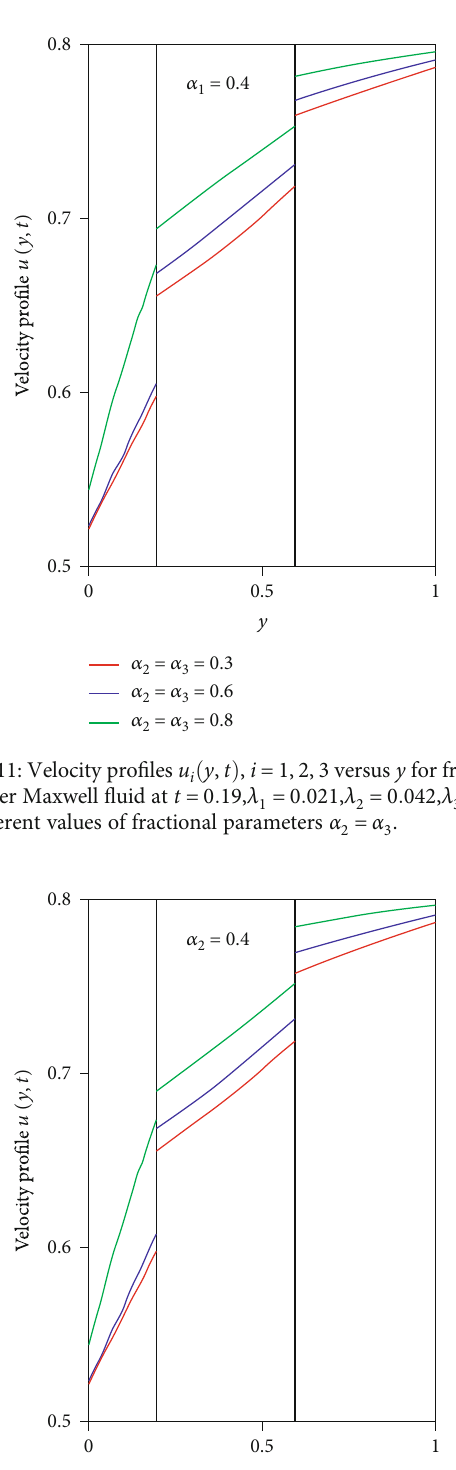
ð y , t Þ , i = 1, 2, 3 versus y for fractional i = 0 : 021, λ = 0 : 042, λ = 0 : 06, 1 2 3 = α . 1 3